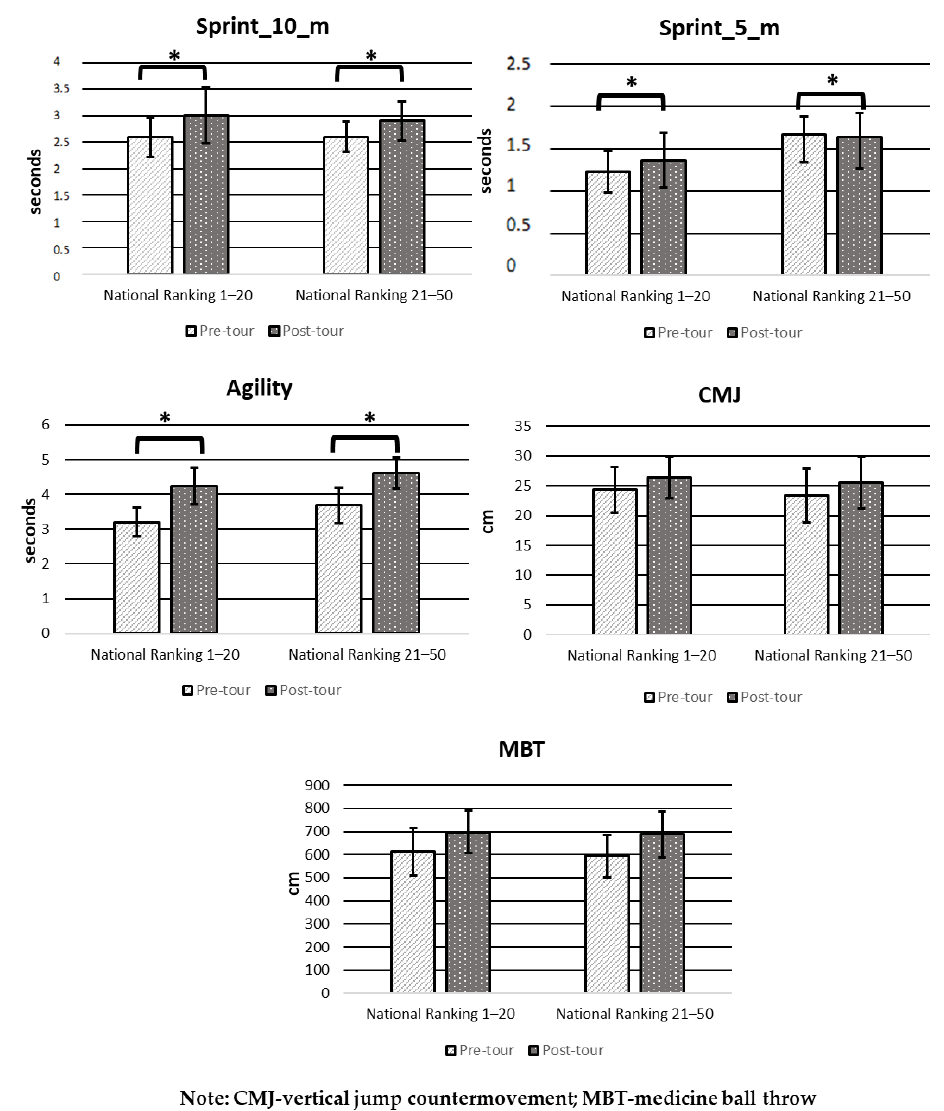
Figure 2. Mean and SD in pre- and post-tour physical performance tests by Chilean junior tennis ranking.